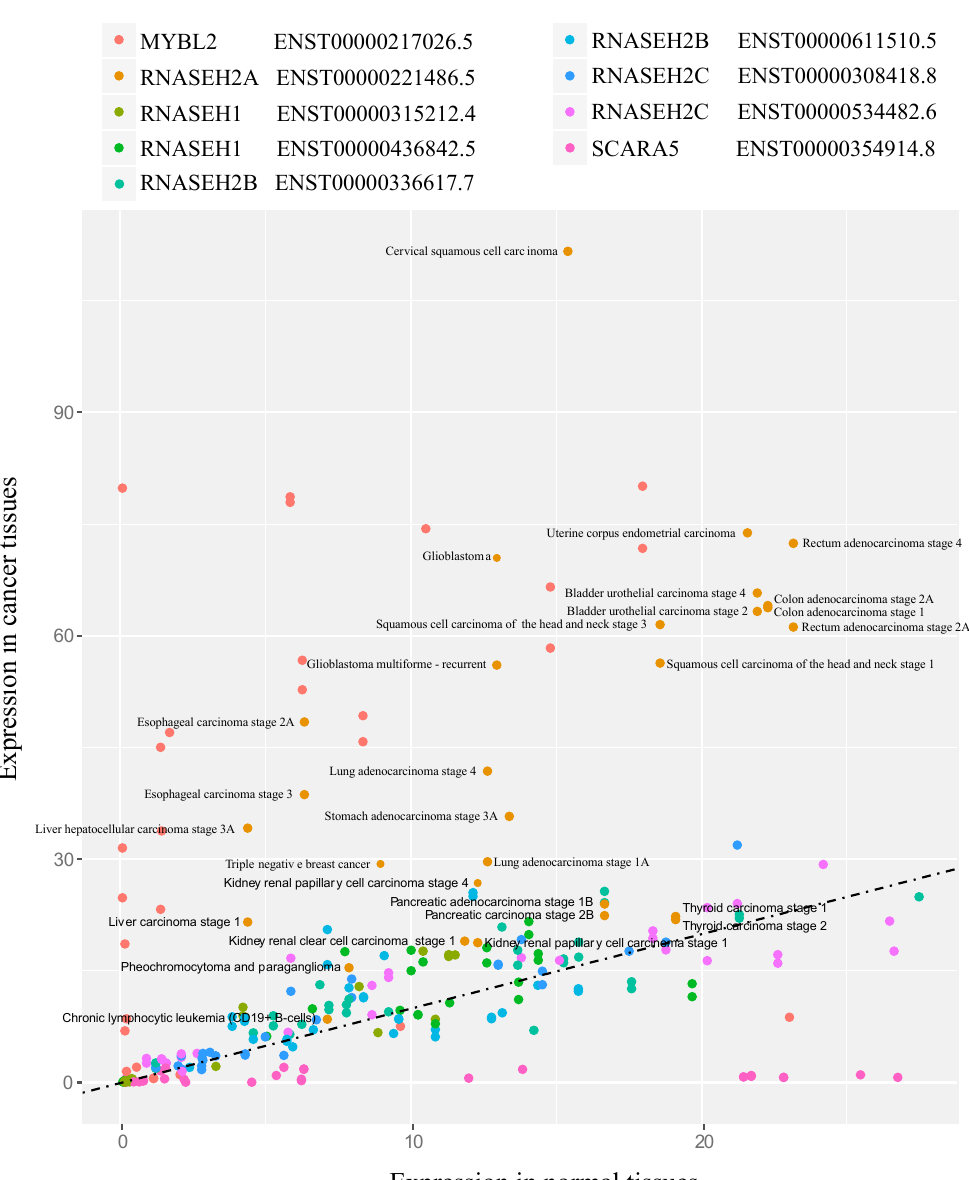
Figure 2. RNASEH2A gene expression in cancer tissues. Expression levels in TPM and only for triple negative breast cancer and chronic lymphocytic leukemia in fragments per kilobase million (FPKM) in 29 different cancer tissues compared to non-cancerous tissue controls. Data obtained from Cancer RNA-seq Nexus (CRN). Regression line represents equal expression levels in cancer and normal tissues.